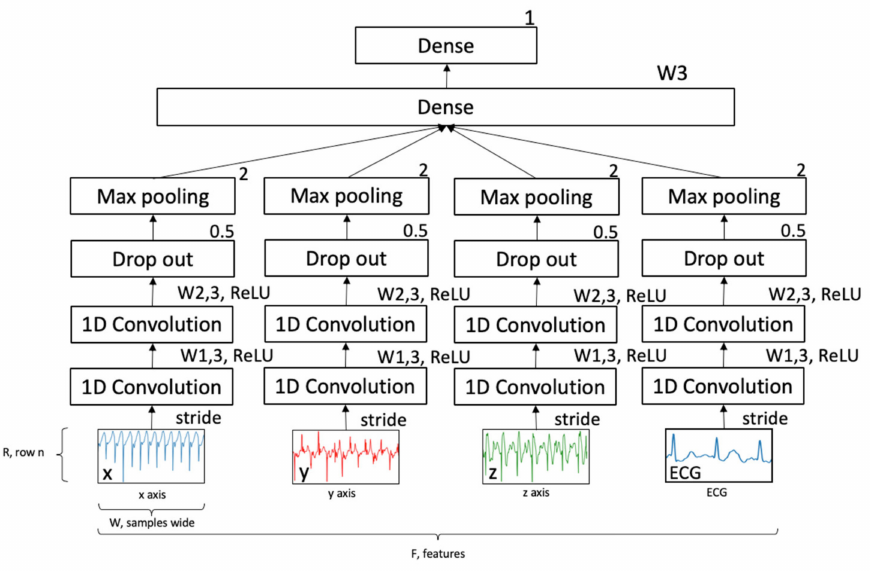
Figure 3. Structure of